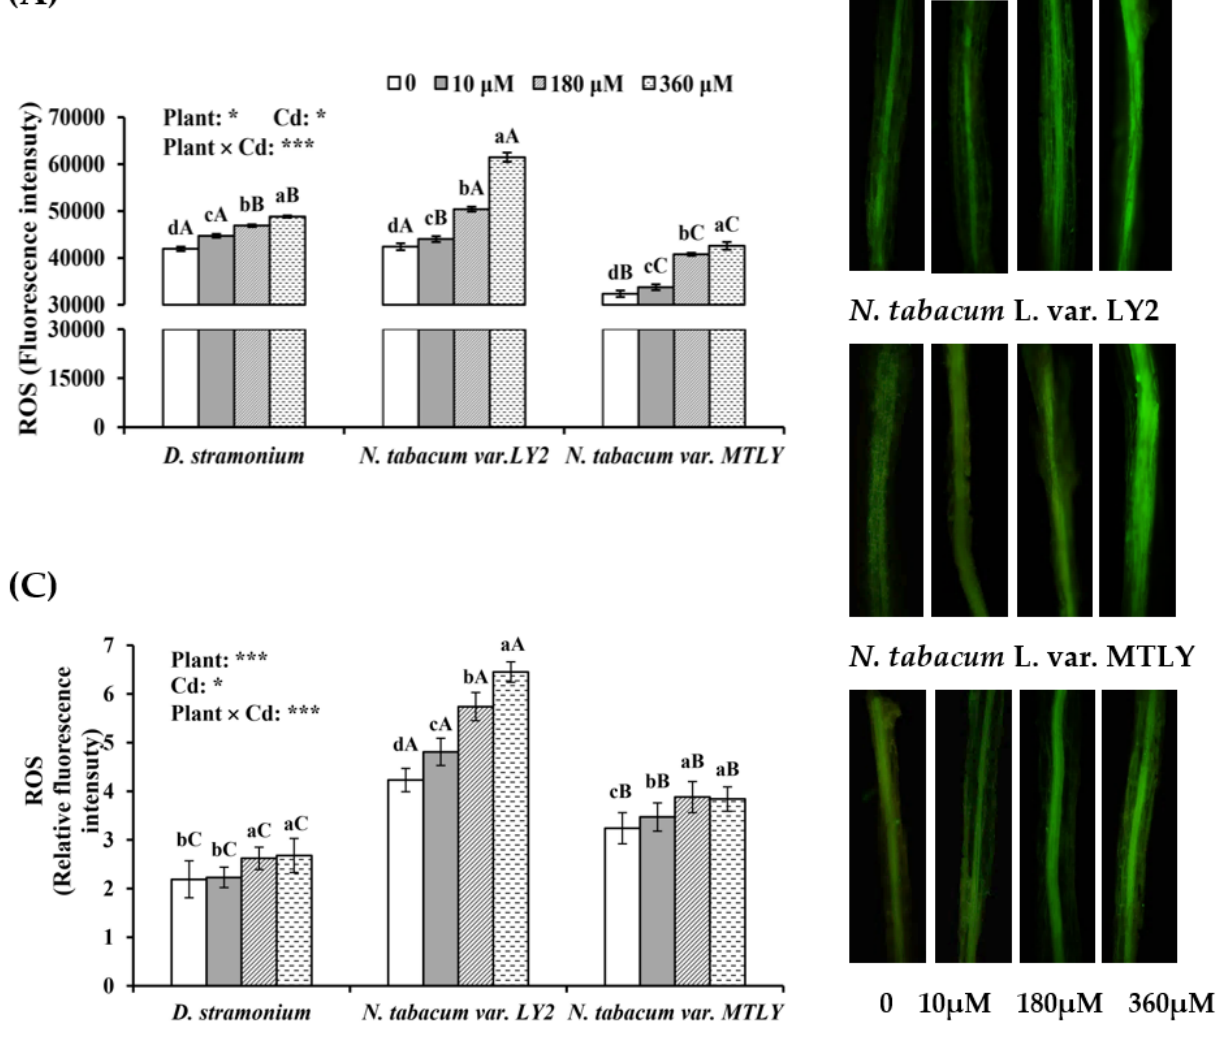
Figure 4. Cd-induced oxidative stress in seedlings. ( A ) Reactive oxygen species (ROS) generation in leaves. DCFH-DA staining of ROS ( B ) and its relative fluorescence intensity ( C ) in root tips. Values were expressed as means ± SD ( n = 9). Different lowercase letters on the bars indicated significant differences between the same material under different Cd concentrations. Different uppercase letters on the bars indicated significant differences between different materials under the same Cd treatment ( p < 0.05). GLM was used to assess the effects of plant materials, Cd treatments and their interactions on test results. The signi fi cance was indicated as follows: * 0.01 < p ≤ 0.05; *** p ≤ 0.001.